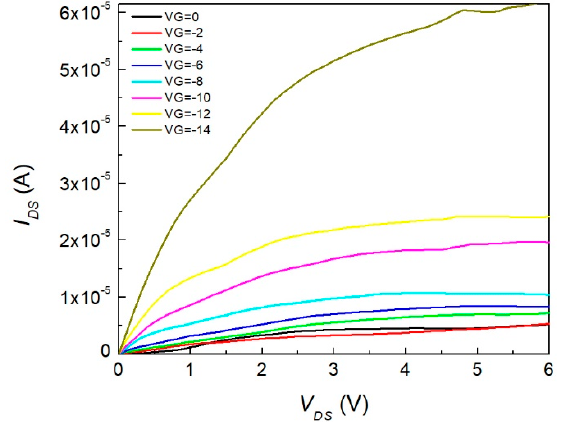
Figure 8. Voltage–current characteristics of the device.